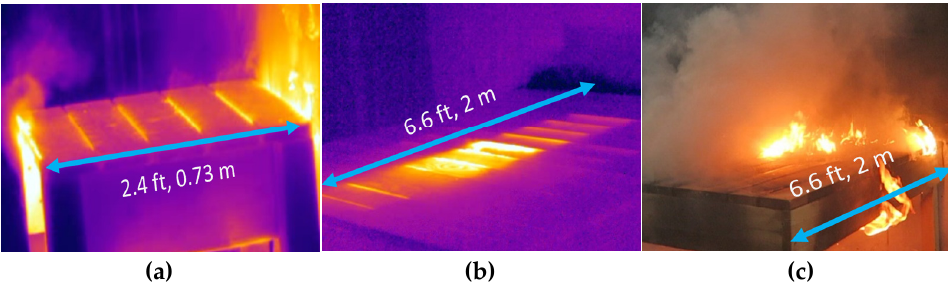
Figure 14. ( a ) Distribution of heat under a 2 ft × 2.4 ft deck 90 s after igniting the burner. ( b ) Distribution of heat under a 6.6 ft × 6.6 ft deck 90 s after igniting the burner. ( c ) Intensity of the fire for a 6.6 ft × 6.6 ft deck 40 min after turning off the burner at no-wind condition.